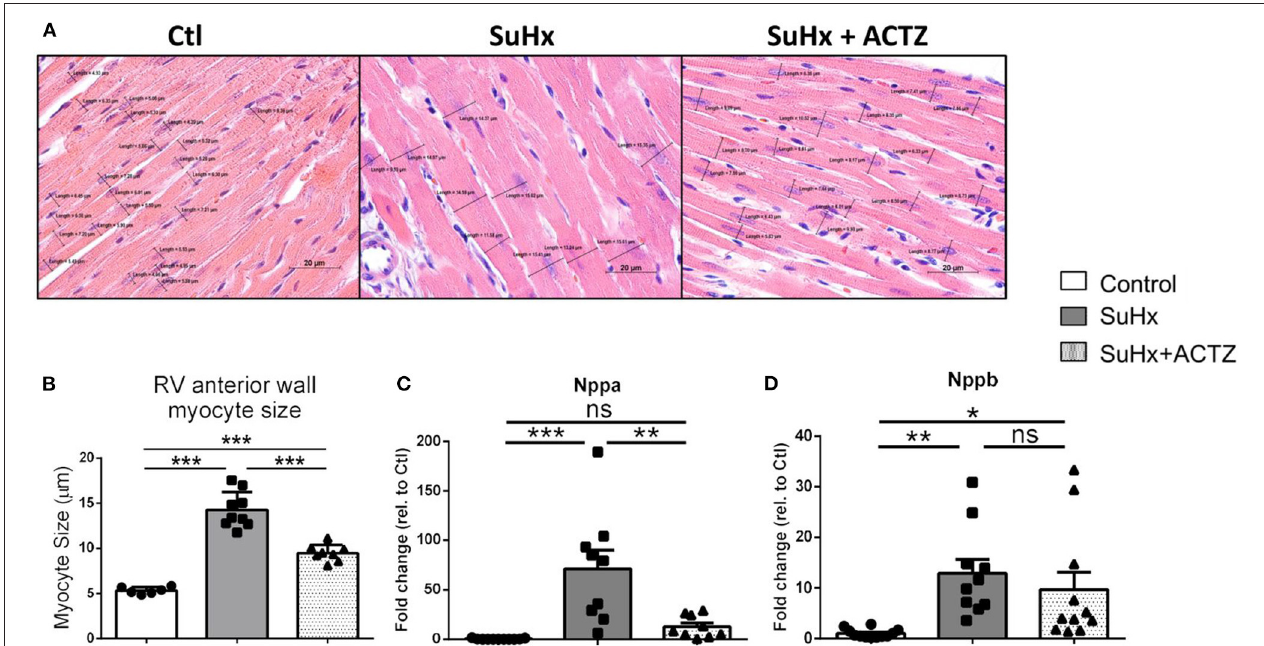
FIGURE 5 | Amelioration of right ventricular (RV) cardiomyocyte hypertrophy in acetazolamide (ACTZ)-treated Sugen 5416/hypoxia (SuHx) animals. (A) Representative longitudinal RV free wall sections stained with hematoxylin and eosin. Black lines indicate cell diameters at the level of the nucleus. Scale bar 20 µ m. (B) Quantitative analysis of myocyte size in the three experimental groups ( n = 6–9 animals per group). Real-time PCR analysis of mRNA levels of the cardiac hypertrophy transcripts (C) atrial natriuretic peptide ( Nppa ) and (D) brain natriuretic peptide ( Nppb ) in RV from the experimental groups ( n = 10–12 per group). Experimental groups: Control, SuHx, and SuHx + ACTZ. Statistical analysis by one-way ANOVA and Tukey’s post-hoc test. Error bars are mean ± SEM. * P < 0.05, ** P < 0.01, and *** P < 0.001.